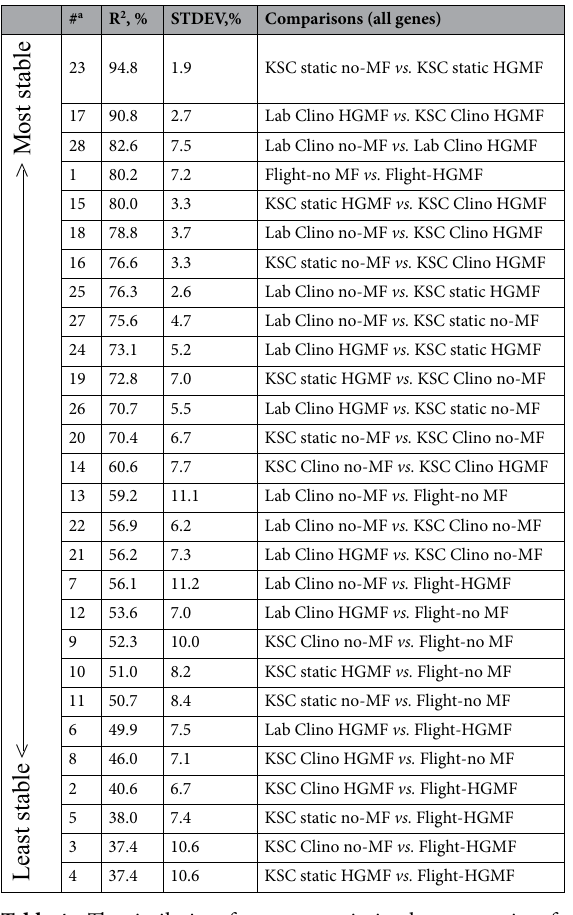
Table 4. The similarity of gene transcription between pairs of treatments based on high gradient magnetic fields (HGMF) or no magnetic fields (no-MF) that were applied during the space flight (Flight), on ground controls (static), or during clinorotation (Clino) at the Kennedy Space Center (KSC) or in the laboratory (Lab). The values were obtained by averaging the R 2 values that resulted from using each of the 16 genes as reference (i.e., origin in graphical comparisons such as Figs. 3 and 5 and Sup. Figs. 3 and 4). a Numbers refer to Sup. Table